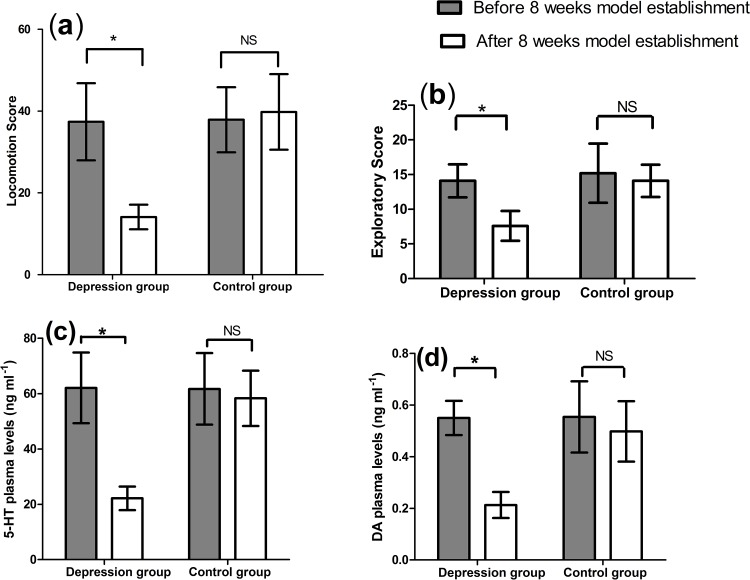
Results of open-field test (A) locomotion score (B) exploratory score and 5-HT (C) and DA (D) plasma levels (n = 9, mean ± SD).∗p < 0.01: before and after score within-group comparison, NS: no significant difference.